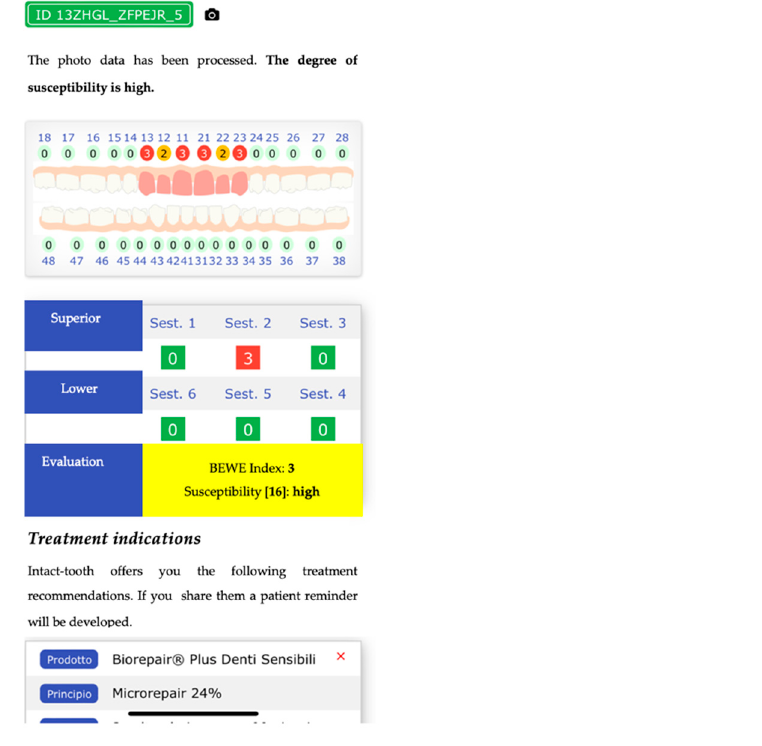
Figure 3. Shows an odontogram with the value of the erosion status, adjudicated by the healthcare professional, and provides the calculation of the BEWE index and the degree of susceptibility, with the most appropriate protocols to treat the patient over time.